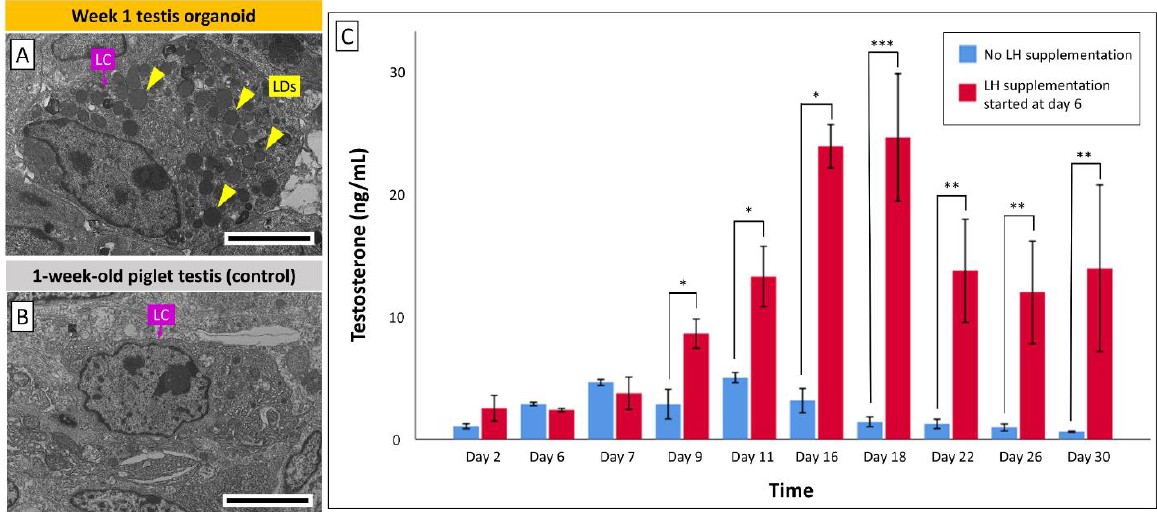
Figure 6. Transmission electron microscopy (TEM) and testosterone measurements to study the androgen synthesis and luteinizing hormone (LH)-responsiveness of Leydig cells (LCs) in testis organoids. ( A ) Lipid droplets (LDs) were observed in an LC of organoid as early as 1 week of culture, indicating initial androgen synthesis and functional maturation of LCs in the organoids. ( B ) An LC in intact testis tissue from a 1-week-old piglet (control) does not contain any LDs. Scale bars: 5 µm. ( C ) Testosterone levels (ng/mL) in the organoid culture media were measured over time via ELISA. Red columns represent LH supplemented groups: LH supplementation in the organoid culture media started at day 6 of culture and continued until the end of experiments (day 30). Blue columns represent control groups without LH supplementation. The higher levels of testosterone during days 9 to 30 of culture suggest that Leydig cells in the organoids can be induced by LH to release more testosterone. Data are presented as mean ± SEM. Data with asterisks differ significantly among groups ( p : * <0.05, ** <0.01, *** <0.005). n = 3 replications.